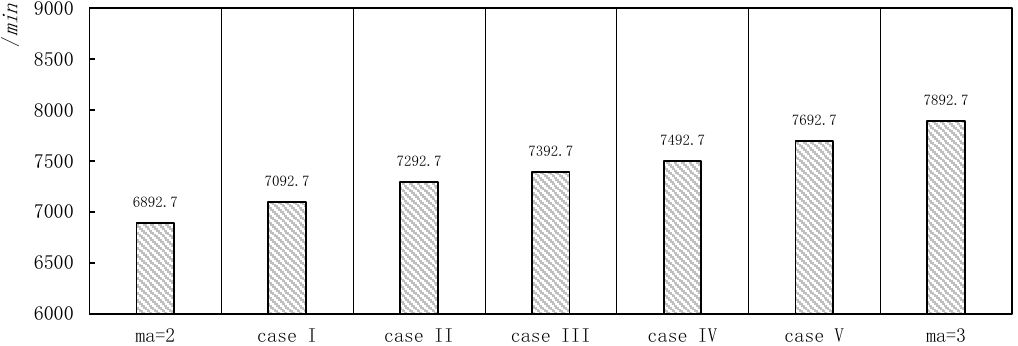
Energies 2018 , 11 , x FOR PEER REVIEW Figure 6. Comparison of the total trip time for various cases. Figure 6. Comparison of the total trip time for various cases.